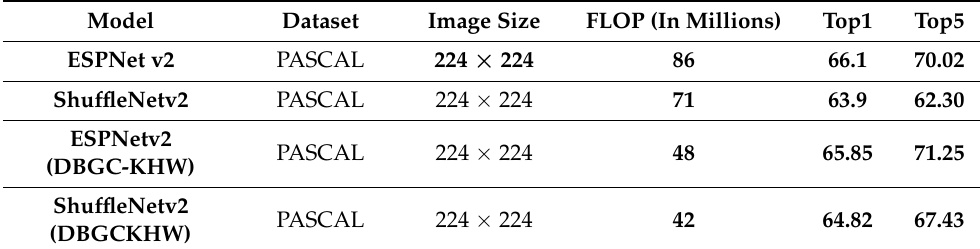
Table 8. Height + width-based kernel. Table 8. Height+width-based kernel.